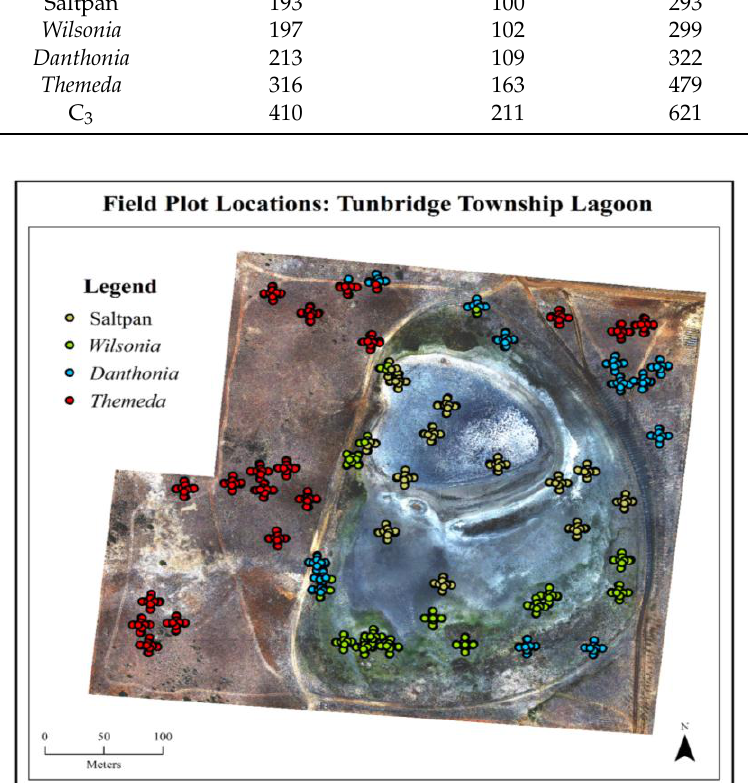
Figure 2. Location of field plots showing transect locations and observation intervals along each transect. The associated vegetation class are for each observation is shown as per the legend. Each point represents the location of three nadir and off-nadir spectral signatures.